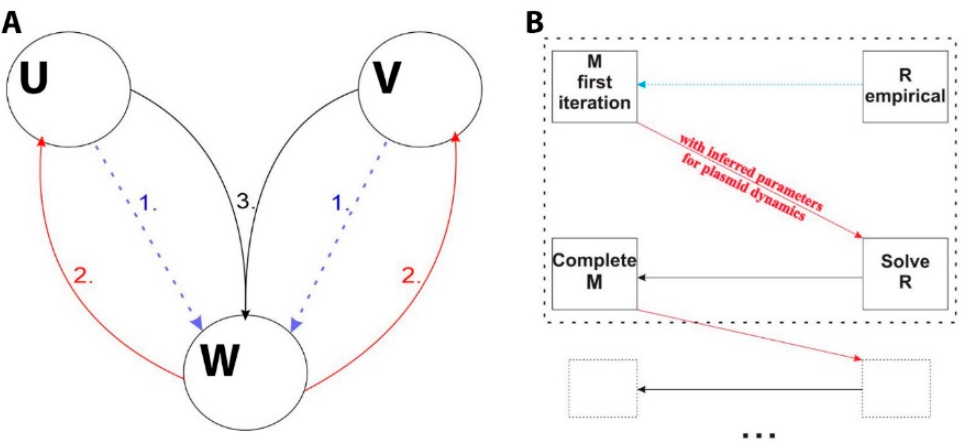
Figure 2. Schematic representation of “mean field-like” procedure for reducing dimensionality of the parameter inference problem for the model with population dynamics effects included. ( A ) Generalized procedure. Circles represent sets of ODEs describing dynamics of particular species (here labeled by U, V and W). The blue dashed arrows denote that in the first step, dynamics of species U and V are empirically approximated and used to determine the parameters of W dynamics by solving only W related ODEs. In the next fitting step (indicated by the red solid arrows and the number 2), the shared parameters (those describing population dynamics) inferred by fitting in the previous step are used in fitting the solution of U and V related ODEs and thereby inferring their corresponding parameters. In the step 3, the fitted (and not the empirically approximated) solution of the U and V related ODEs is used in inferring the parameters of W dynamics. The steps 2 and 3 repeat iteratively until the best fit of the whole model to the data is obtained; ( B ) Applying the procedure to the case of R-M dynamics: boxes represent consecutive fitting steps, and arrows indicate the order of solving the sets of equations corresponding to R and M dynamics. Dashed arrows and squares indicate that the steps in the upper box can be iteratively repeated until convergence is reached. The arrow style and labeling is equivalent as in part A of the Figure.